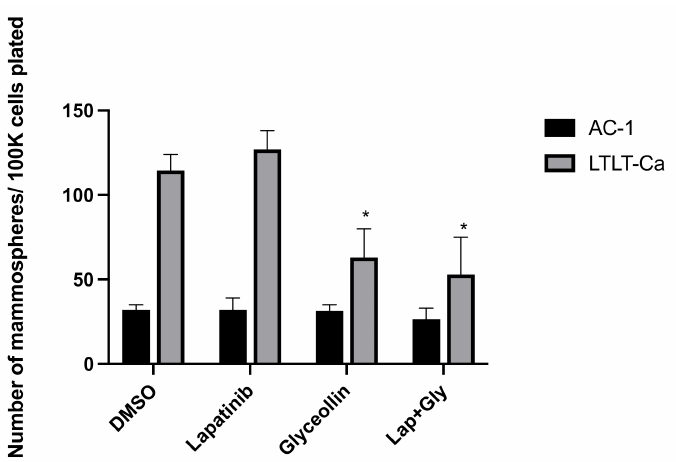
Figure 4. Glyceollin inhibits mammosphere formation in LTLT-Ca cells. Mammosphere formation assays were performed with AC-1 and LTLT-Ca cells. The total number of mammospheres was counted and plotted. * p < 0.05, where treatments were compared to vehicle control. Results are expressed as the mean unit ± standard deviation of 3 independent experiments in